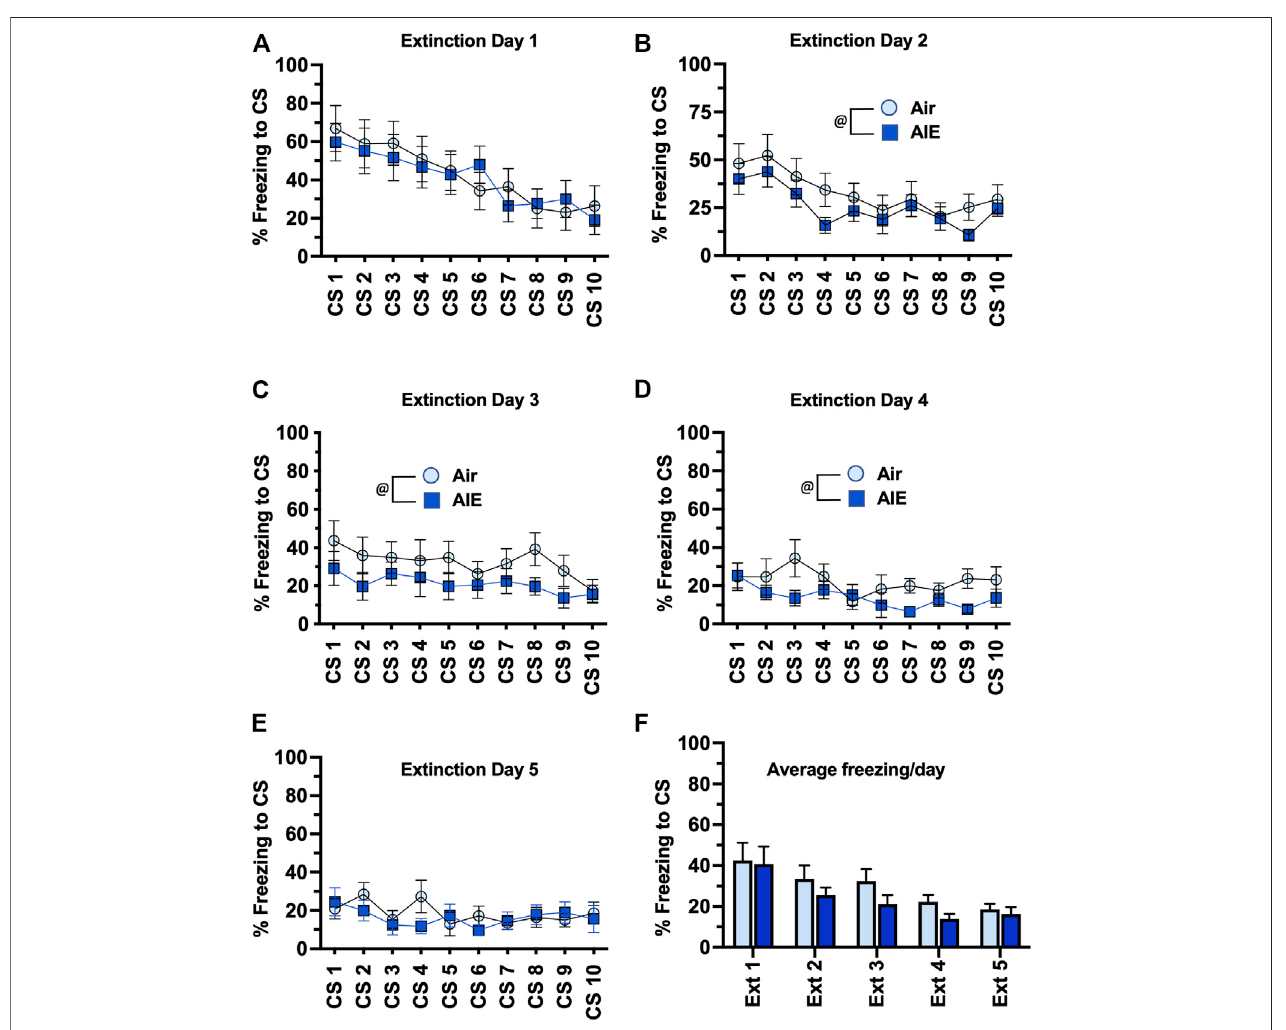
FIGURE 8 | AIE exposure did not alter extinction of conditioned fear in low conditioning (LC) female rats. (A – E) Five consecutive days of presentation of the CS (tone) without the shock (10/session/day) resulted a session-dependent reduction of freezing to presentation of the tone. While AIE exposure was associated with small butstatisticallysigni fi cantlychangesinfreezingbehavioronseveraloftheextinctiondays,comparisonoftheaveragefreezingacrossthe10tonesofeachdailyextinction session (F) revealed there were no signi fi cant differences between the Air control and AIE exposed rats. Air, n = 6; AIE, n = 9. @, signi fi cant main effect of AIE exposure (all p values < 0.05). Air, n = 12; AIE, n = 9.